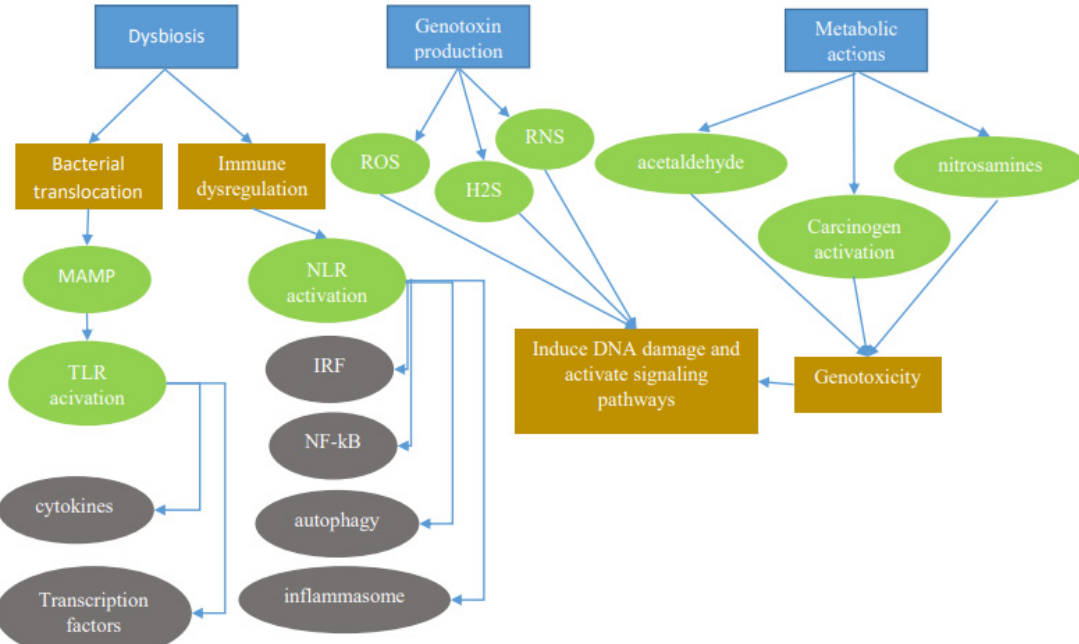
Figure 1. The microbiota promotes carcinogenesis through di ff erent mechanisms (blue rectangles). Dysbiosis can induce carcinogenesis through bacterial translocation and immune dysregulation. Through bacterial translocation, microorganism-associated molecular patterns (MAMPs) activate Toll-like receptors (TLRs), which in turn activate cytokines and transcription factors. Through immune dysregulation, nod-like receptors (NLRs) activate multiple signal pathways to induce the formation of inflammasomes and / or activate nuclear factor κ B (NF- κ B), stress kinases, interferon regulatory factors (IRFs), inflammatory caspases, and autophagy Genotoxins such as reactive oxygen species (ROS), reactive nitrogen species (RNS), and hydrogen sulfide (H2S) released by certain bacteria can have detrimental e ff ects. Also, metabolic actions of bacteria activating toxins such as acetaldehydes and nitrosamines can also result in a genotoxic e ff ect leading to